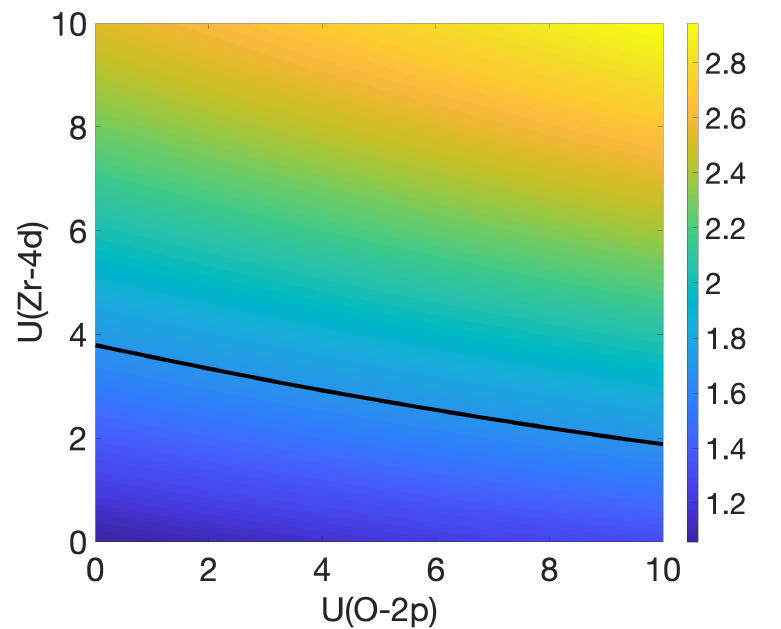
Figure 6. Calculated V O diffusion barrier as a function of the Hubbard-U parameters. The black line indicates the barrier height from a hybrid DFT calculation (using